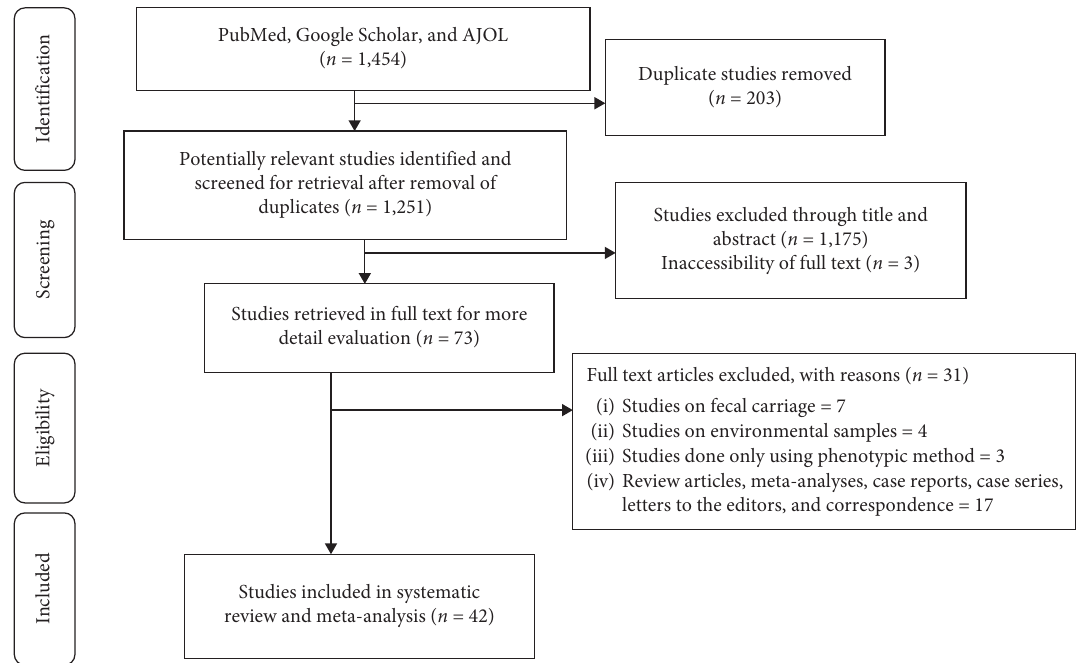
Figure 1: Flow chart shows the study selection